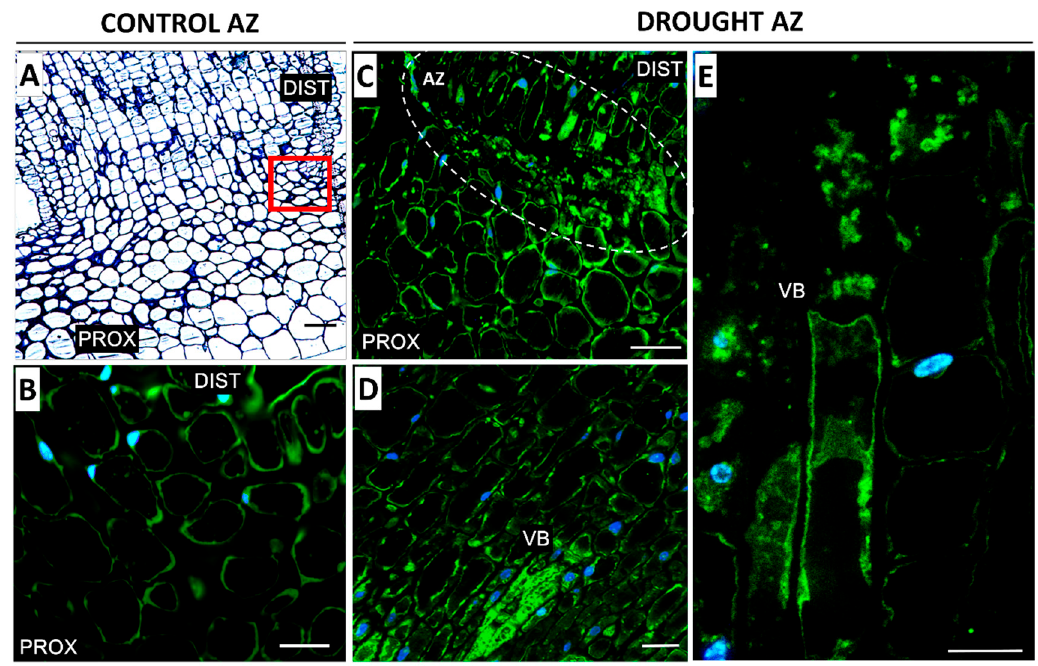
Figure 4. Immunofluorescence localization of MPK6 in the abscission zone (AZ) of yellow lupine flowers grown under drought conditions ( C – E ) and in the control AZ ( B ). The AZs were excised on the 48th day of development. Control plants were cultivated under optimal soil conditions (70% WHC), whereas stressed plants were subjected to drought for 2 weeks (25% WHC). The AZ region of stressed plants was highlighted by white lines ( C ). Images D and E present the vascular bundle area. Nuclei were stained with DAPI. The examined region of control AZ used in the immunofluorescence studies os indicated by a red square ( A ). Abbreviations: PROX—stem fragments below the AZ, DIST—flower pedicel fragments above the AZ, VB—vascular bundles. Scale bars: 100 µ m ( A , C ), 40 µ m ( B , D , E ).